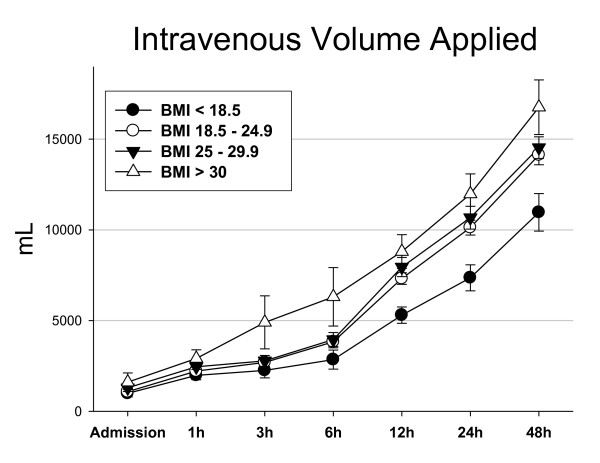
Total amount of intravenous volume applied. Error bars indicate the standard error of the mean.